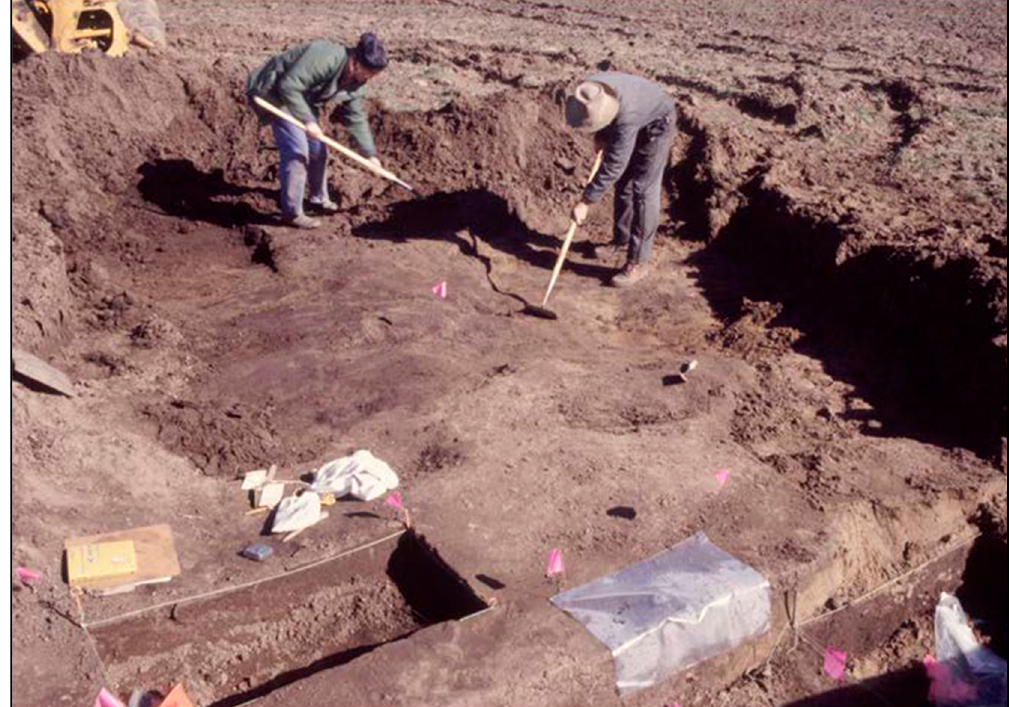
Figure 13. Paleoseismic investigation at an archeological site in the New Madrid seismic zone [130]. The contact between the plow zone and the underlying sand blow is examined for features, such as cultural pits and tree-root casts, that may help to constrain the minimum age of the sand blow. Photograph by M. Tuttle.